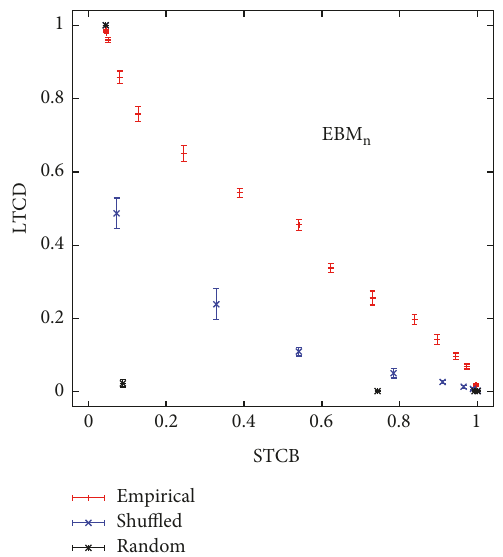
Figure 5: The correspondence between long-term cultural diversity (LTCD)andshort-termcollectivebehavior(STCB)fortheempirical (red),shuffled (blue),and random(black) setsofcultural vectors, for the nominal part of the Eurobarometer dataset (EBM n ). Error bars denote standard deviations over multiple cultural dynamics runs. There are 𝑁 = 500 elements in each set of cultural